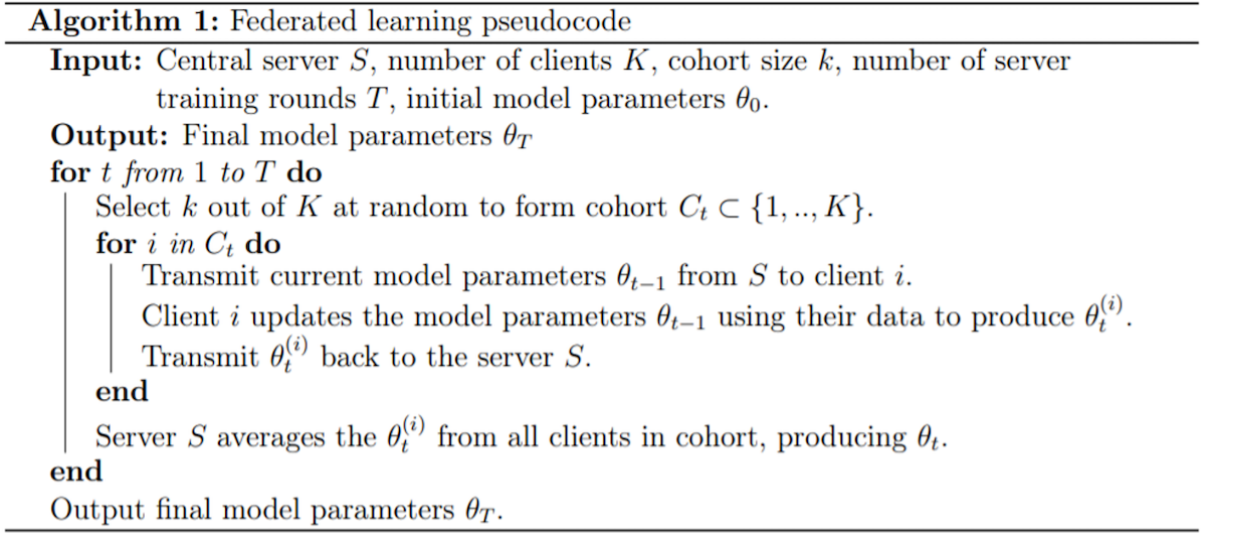
Figure 2. Pseudocode for federated learning algorithm